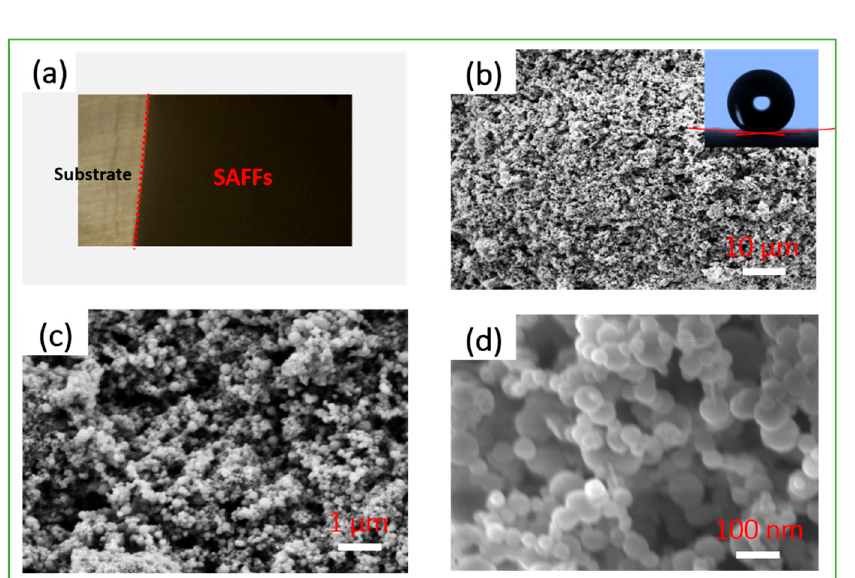
Figure 3. The optical photograph ( a ) and typical SEM images ( b ) of the product. Following are the high resolution FESEM images ( c , d ) of the samples. The image embedded in Figure 3b shows the static hydrophobic angle of ca. 170°.